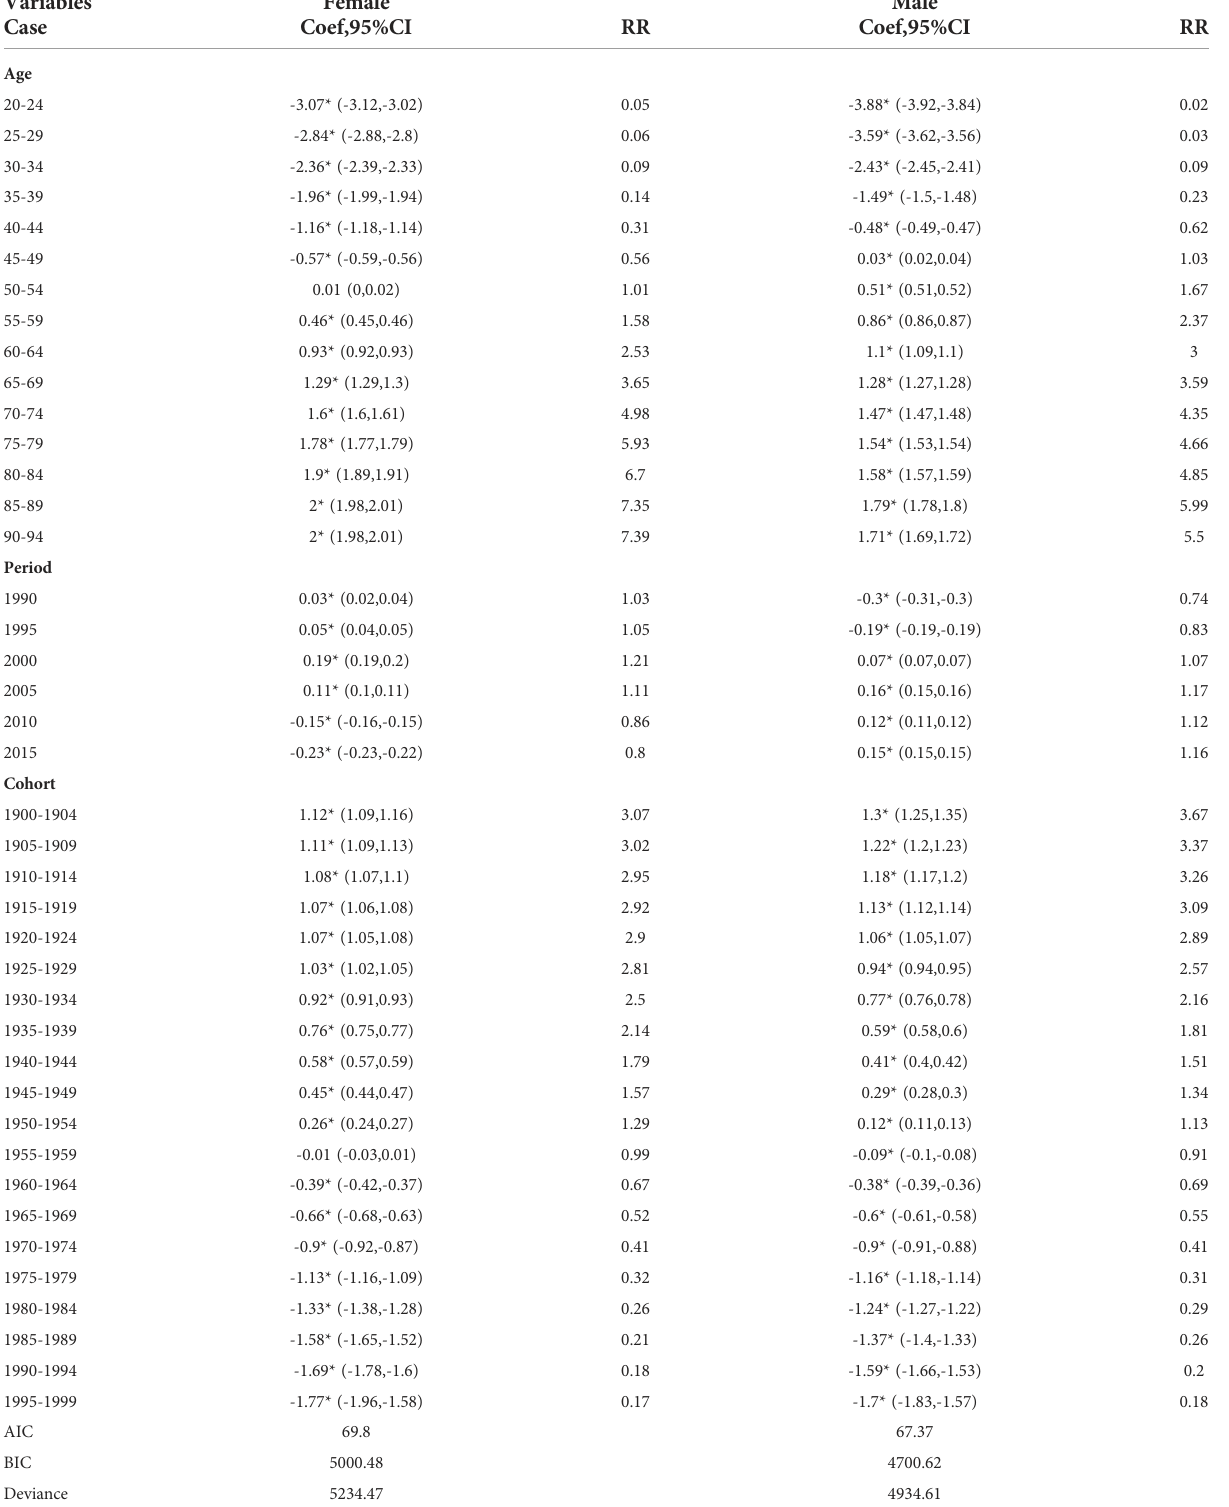
TABLE 4 Age – period – cohort (APC) model analysis results of esophageal cancer mortality in